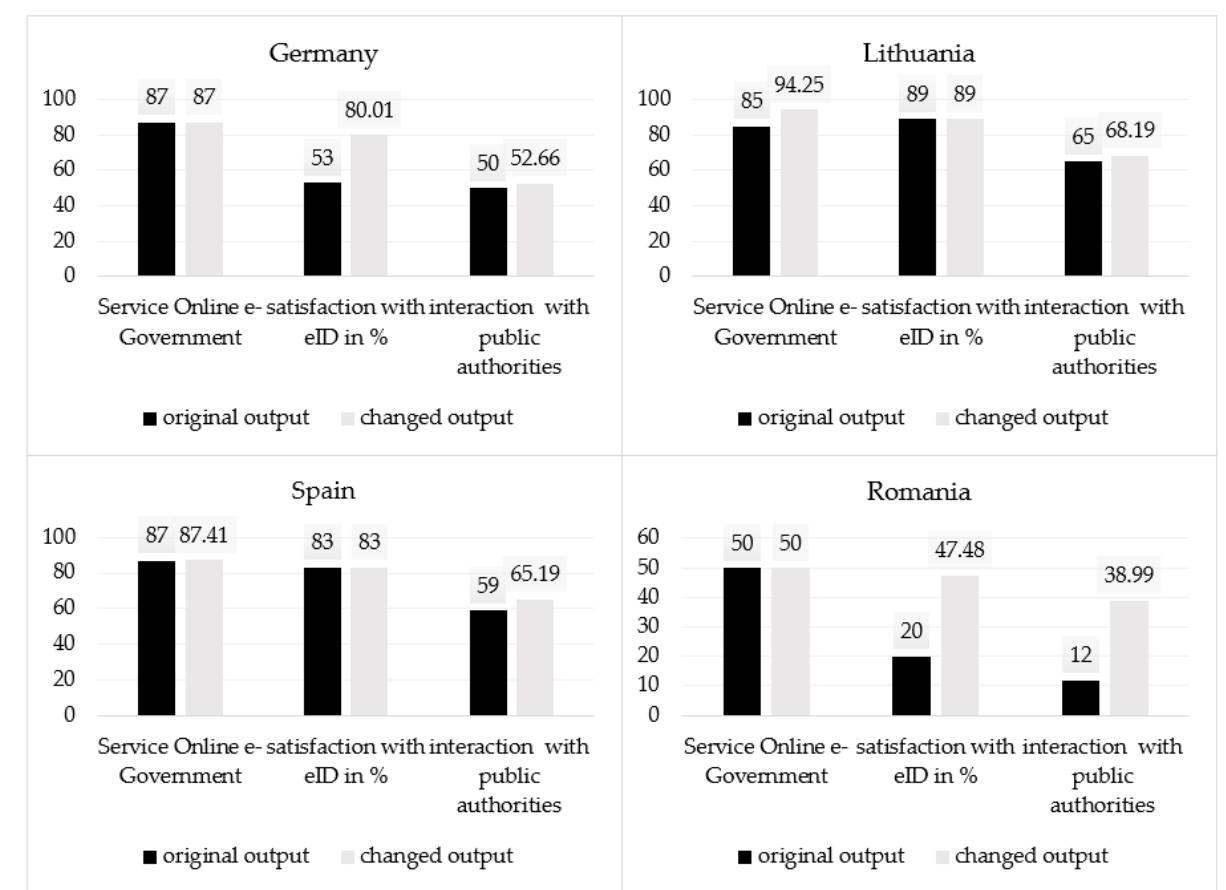
Figure 7. Selected co untries and their change in output.